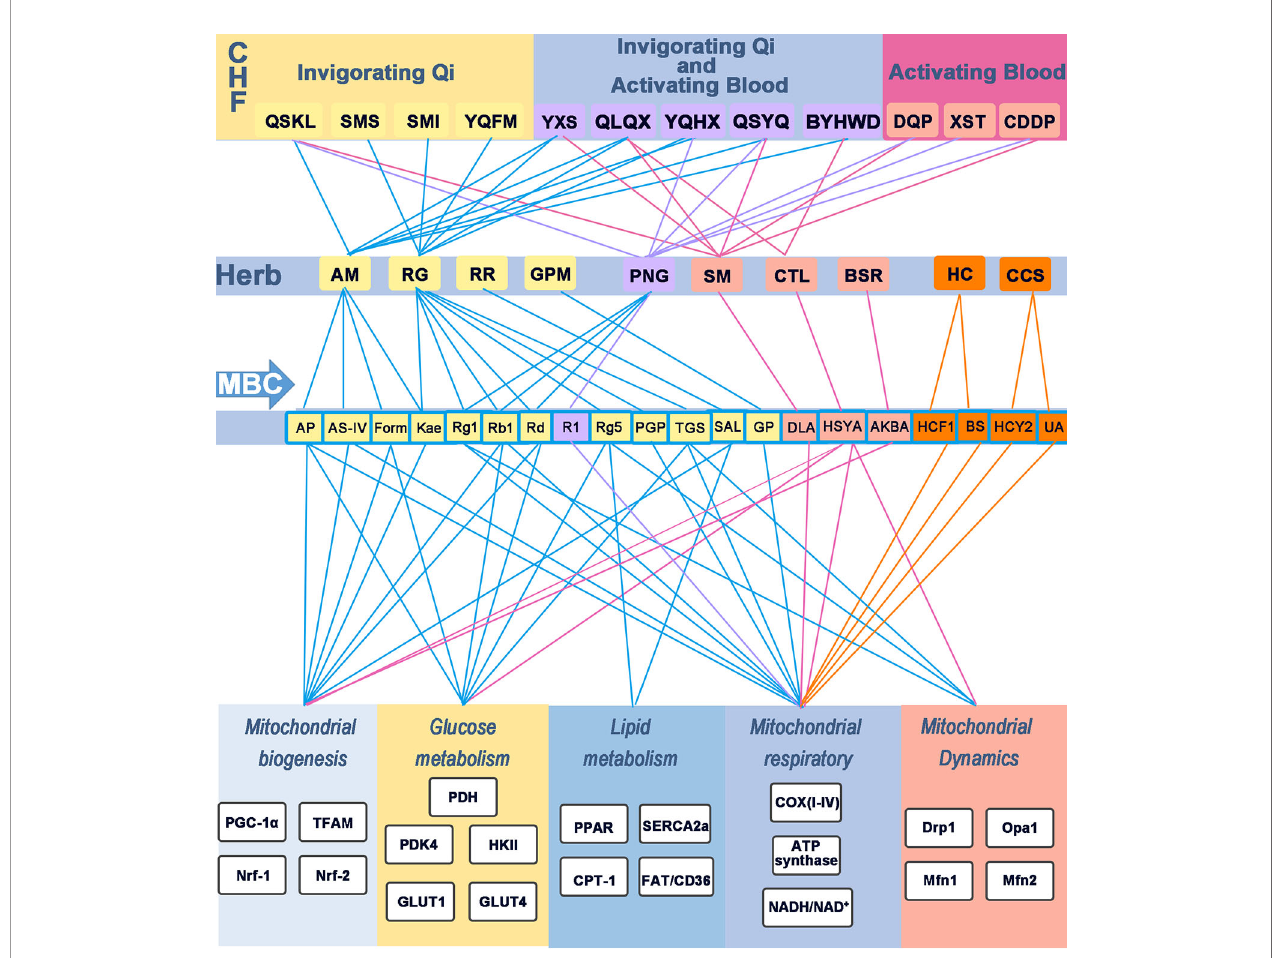
FIGURE 3 | Modulatory effects of CHF, herb, and MBC on energy metabolism in IHD. Chinese herbal formulas, herbs, and the major bioactive component regulate energy metabolism in IHD. Different colored rounded rectangle and lines indicates the different function. The yellow rounder rectangle represents invigorating Qi effects; The purple rounder rectangle represents invigorating Qi and activating Blood effects; The pinkish-orange indicates the formula or herbs with activating Blood; The orange rounder rectangle indicates invigorating Yang effects. Blue lines indicate the relation of herbs with invigorating Qi effects; Purple lines represent the effects of replenishing Qi and activating Blood; Rose lines indicate the effects of activating Blood; And the orange lines represent replenishing Yang. CHF, Chinese herbal formulas; MBC, major bioactive component; COX(I-V), mitochondrial complex (I-V); QSKL, Qishen granules; SMS, Shengmaisan; SMI, Shengmai injection; BYHWD, Buyanghuanwu Decoction; XST, Xuesaitong injection; YXS, Yangxinshi tablet; YQHX, Yiqihuoxue Decoction; YQFM, Yiqifumai powder injection; CDDP, compound Danshen dripping pills; DQP, Danqi pills; AM, Astragalus membranaceus ; AS-IV, Astragaloside IV; AP, Astragalus polysaccharide; DLA, danshensu; Kae, Kaempferol; Form, Formononetin; RG, Radix Ginseng ; Rb1, ginsenoside Rb1; Rg1, ginsenoside Rg1; Rg5, ginsenoside Rg5; PNG, Panax Notoginseng ; R1, Notoginsenoside R1; GPM, Gynostemma pentaphyllum (Thunb.) Makino; RR, Rhodiola rosea L .; SM, Salvia miltiorrhiza ; CTL, Carthamus tinctorius L; BSR, Boswellia serrata Roxb.; HC, Herba Cistanches; CCS, Cynomorium coccineum subsp.; NADPH oxidase, nicotinamide adenine dinucleotide